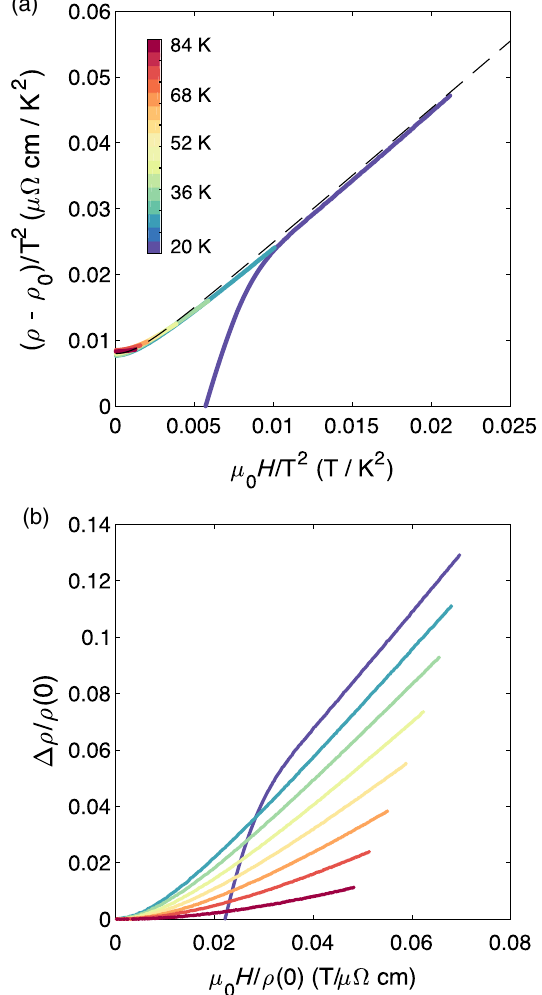
FIG. 5. Comparison of hyperbolic magnetoresistance scal- ing and Kohler ’ s rule inside the AFM ordered state of Þ BaFe 2 ð As 0 P 0 2 . (a) A simple hyperbolic scaling relation . 81 . 19 holds, where the residual resistivity ρ 0 ¼ 122 μ Ω cm is first subtracted. The dashed black line is the expression given by Eq. (9) with β ¼ 0 . 0039 ½ μ Ω cm = K 2 (cid:2) , α 0 ¼ 0 . 0085 ½ μ Ω cm = K 2 (cid:2) , and γ ¼ 0 . 0015 ½ T = K 2 (cid:2) . (b) Kohler ’ s rule is violated as a function of